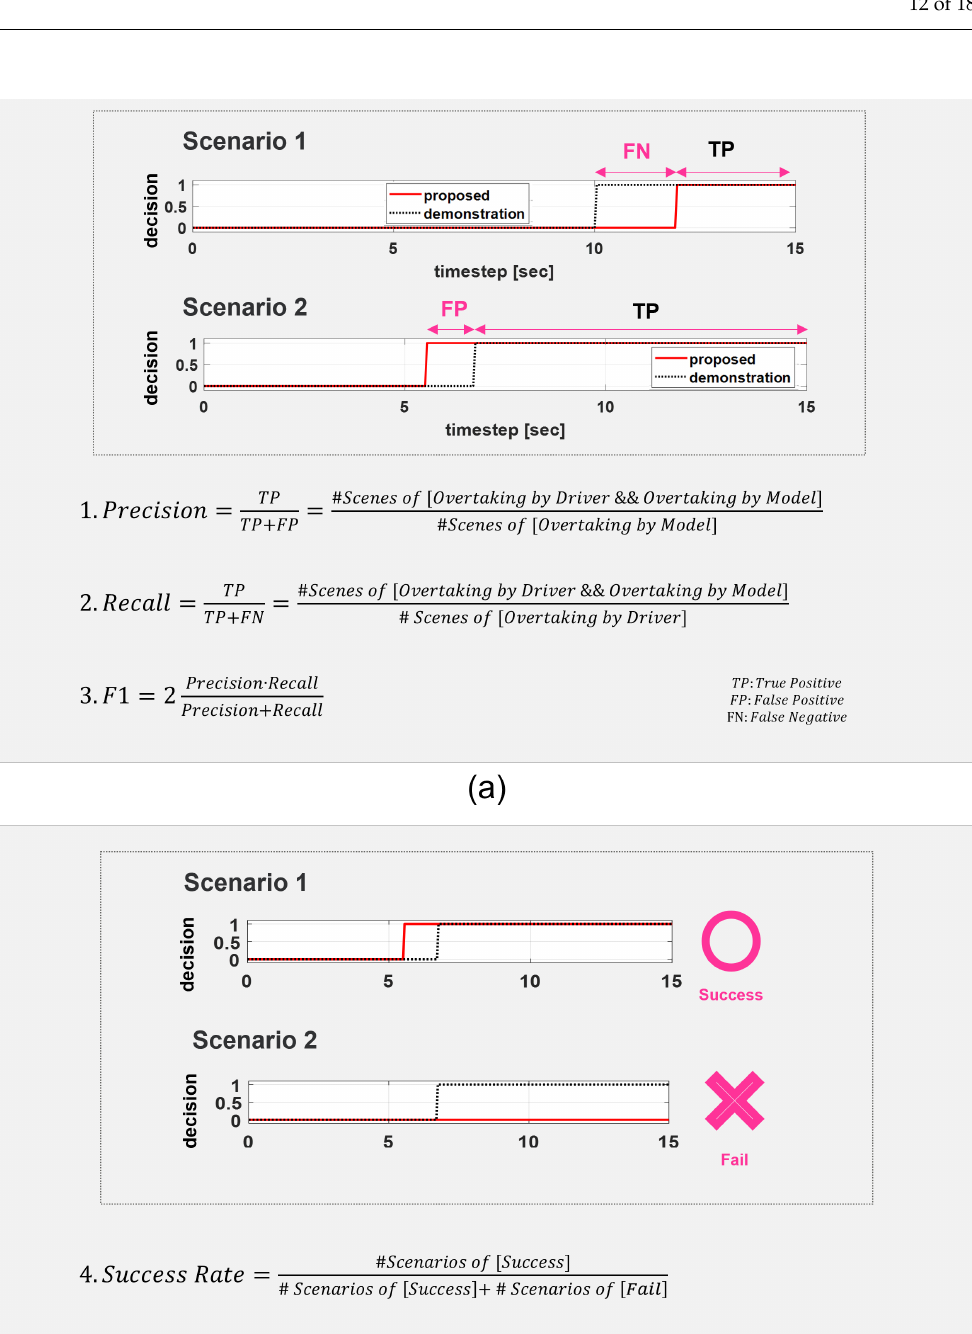
Figure 12. Evaluation metrics and their practical meaning: ( a ) Precision is the fraction of overtaking decisions executed by both the driver and the model among the overtaking decisions by the model. Recall is the fraction of overtaking decisions executed by both the driver and the model among the overtaking decisions by the driver. F1 is the harmonic mean of the precision and the recall; ( b ) Success rate is the fraction of success scenarios among the entire scenarios. A scenario is counted as a success scenario if the final decision of the driver and that of the model are